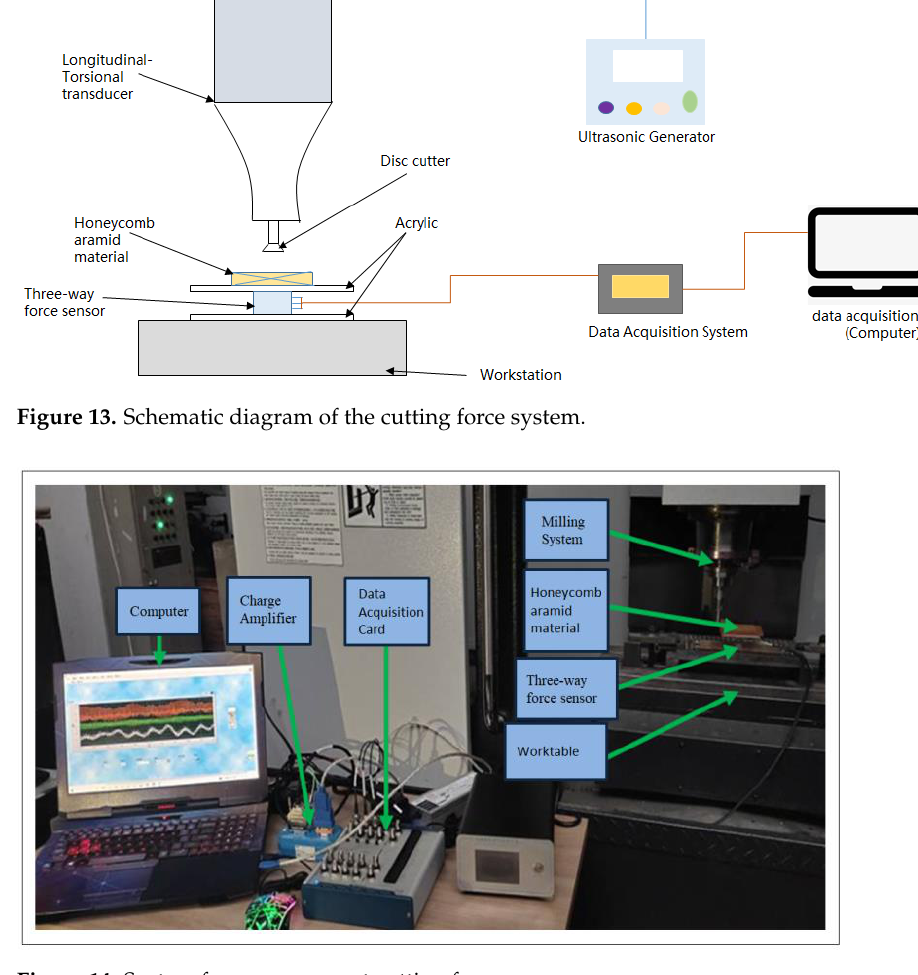
Figure 14. System for measurement cutting force.